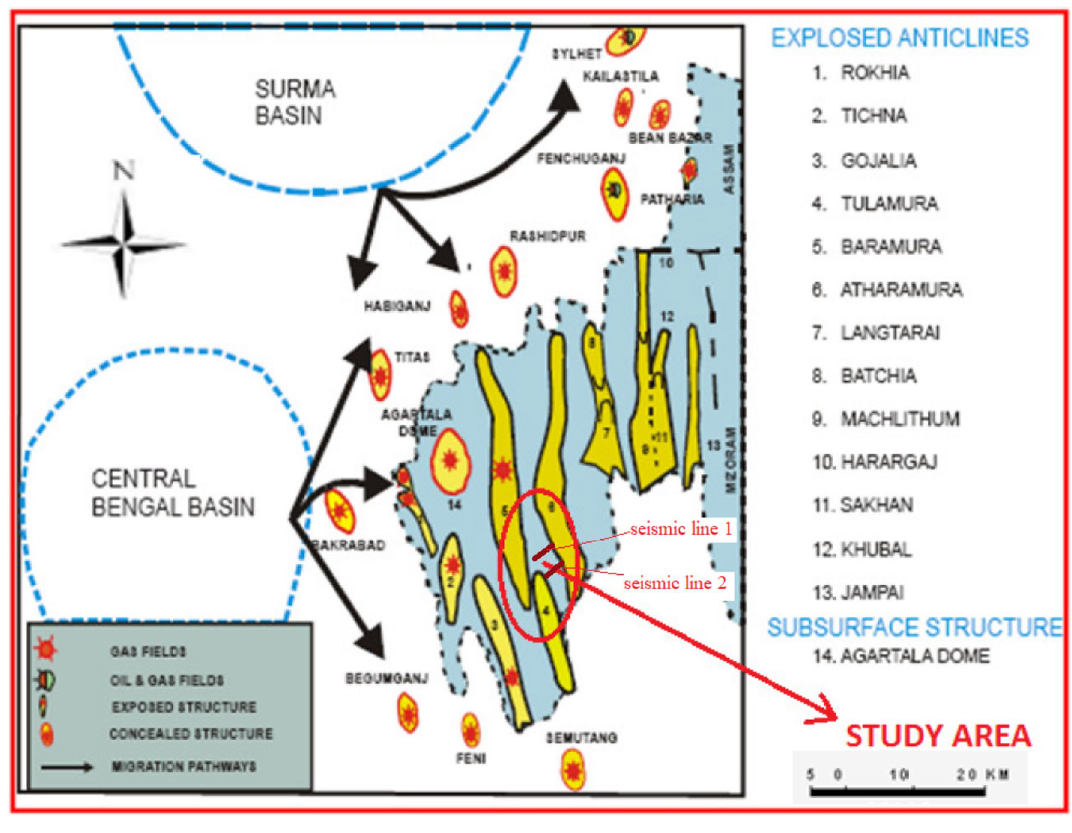
Fig. 2 Study area: Tulamura, Baramura and Atharamura anticlines (Jena et al.